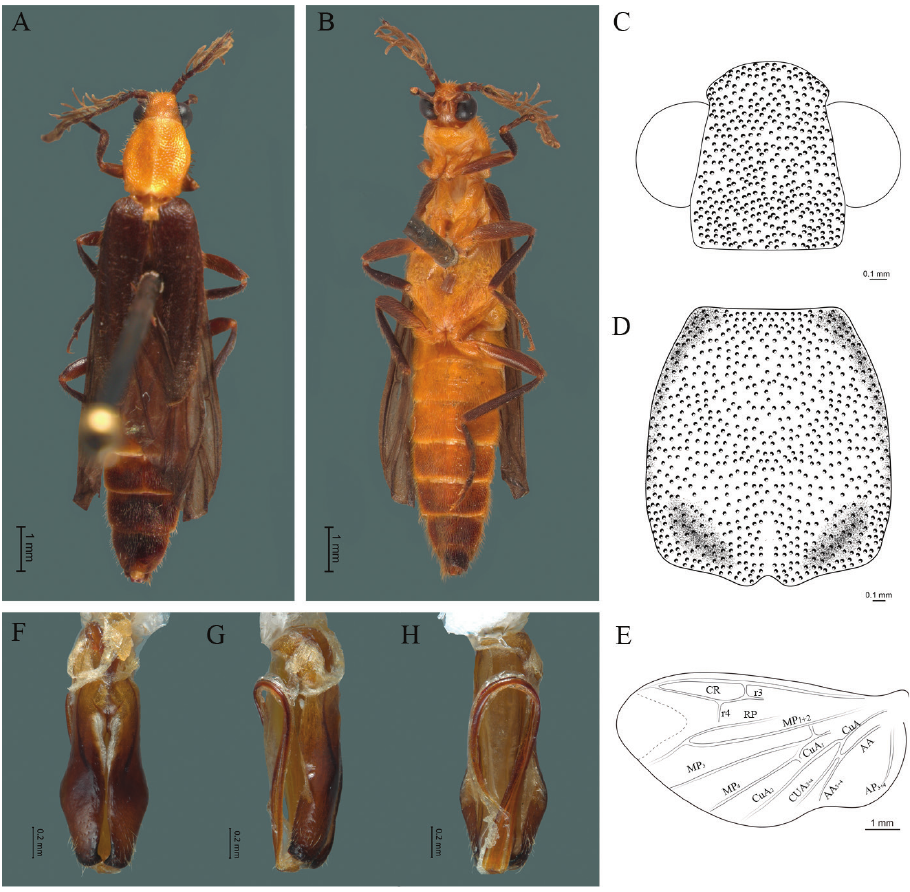
Figure 16. Cenophengus major Wittmer, 1976, male. Habitus: A dorsal B ventral C head dorsal D pronotum dorsal E hind wing. Wing venation: CR = Radial Cell; r3 = radial 3 vein; r4 = radial 4 vein; RP = Posterior Radial vein; MP1+2 = Posterior Median vein; CuA = Cubital vein; AA and AP = Anterior and Posterior Anal veins. Aedeagus: F dorsal view G lateral view H ventral